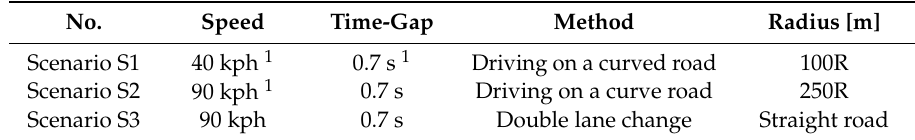
Table 3. Test scenarios for